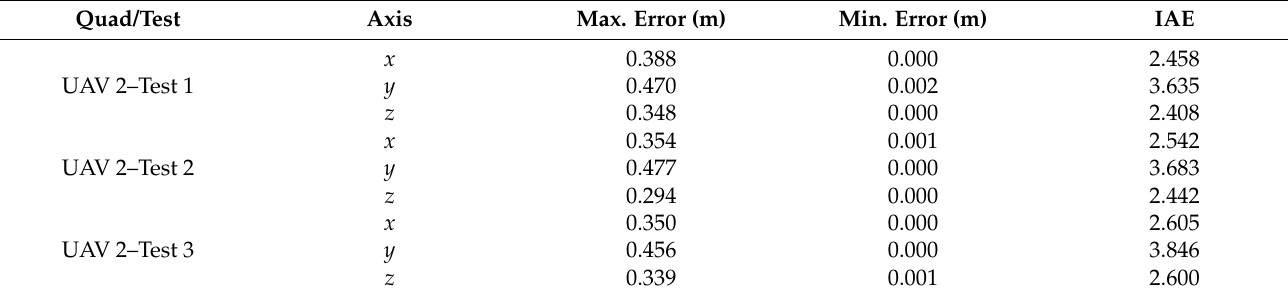
Table 7. Test results for